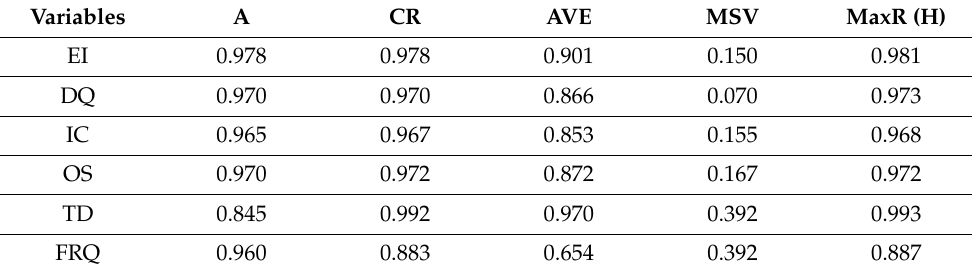
Table 2. Convergent validity for the overall measurement model.